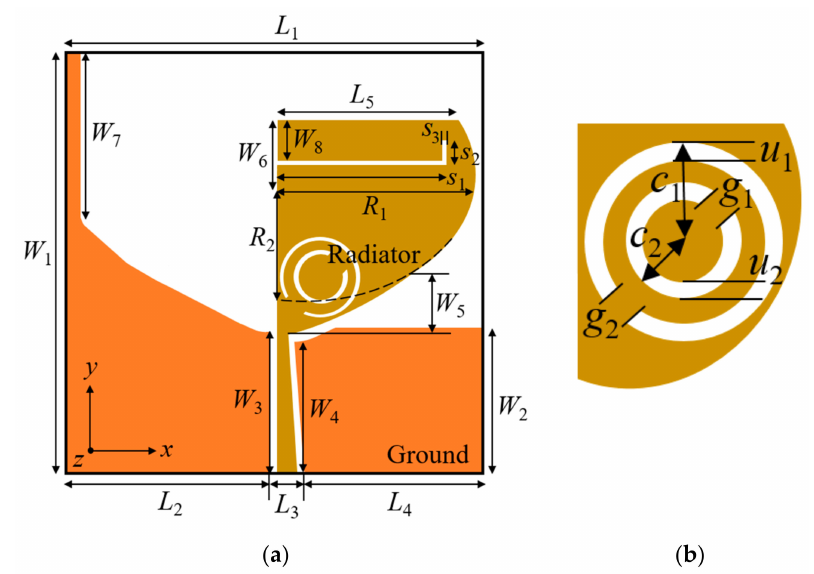
Figure 4. Proposed TSESC resonating element: ( a ) geometric layout; ( b ) magnified view of the implanted complementary split-ring resonator (CSRR).